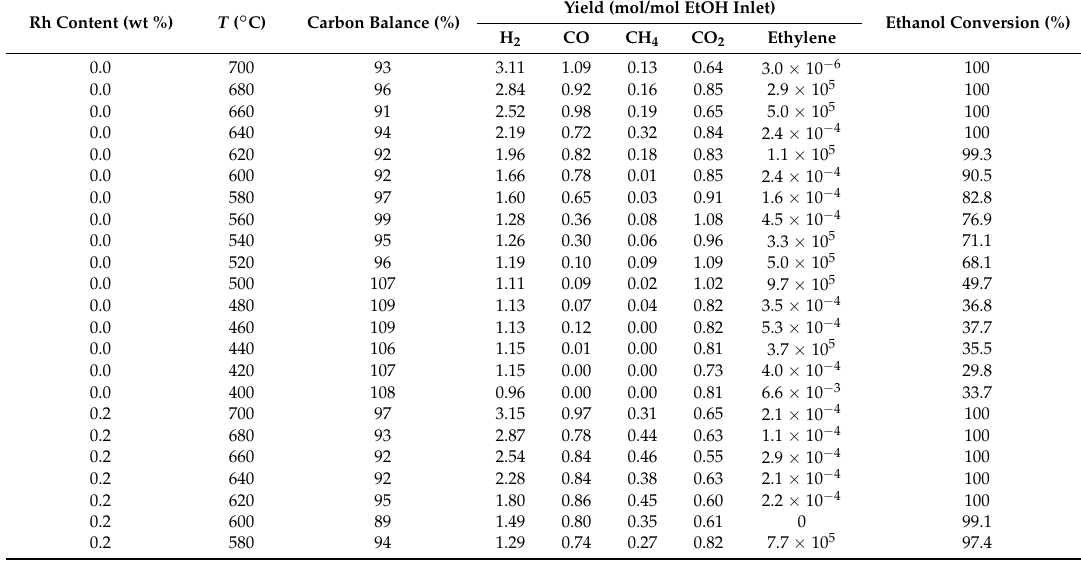
Table A1. Experimental results used to obtain response surfaces and carbon